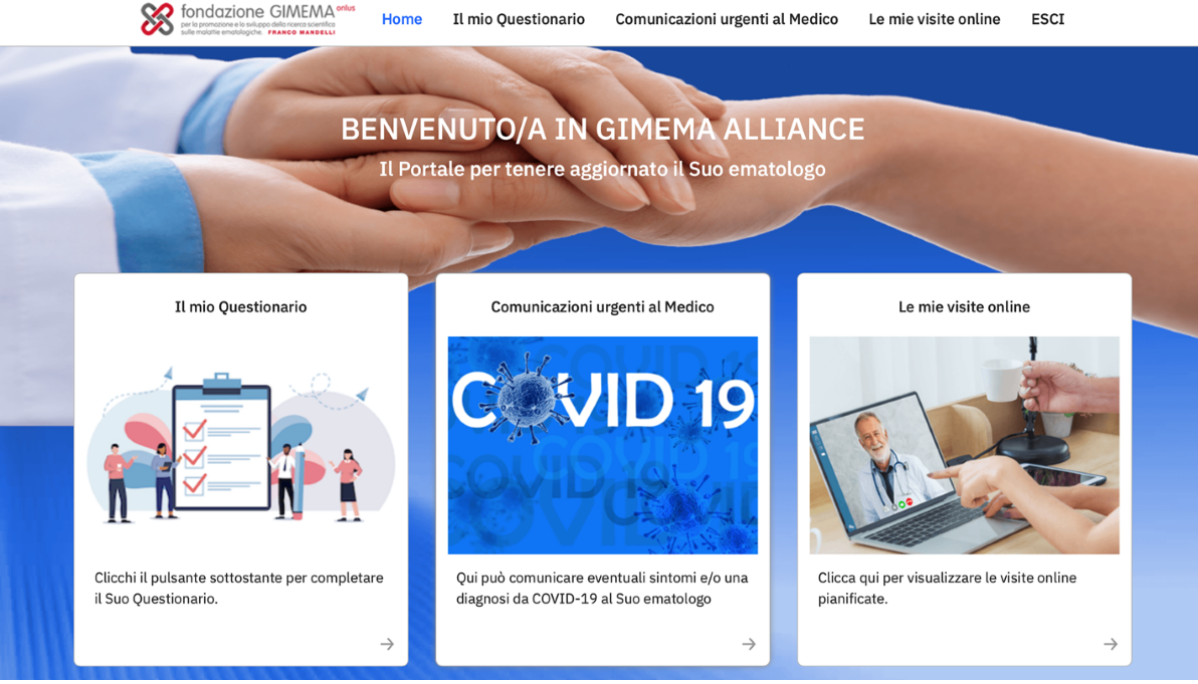
Figure 2. GIMEMA-ALLIANCE patient portal. ALLIANCE: An online platform to improve patient-centered care during the COVID-19